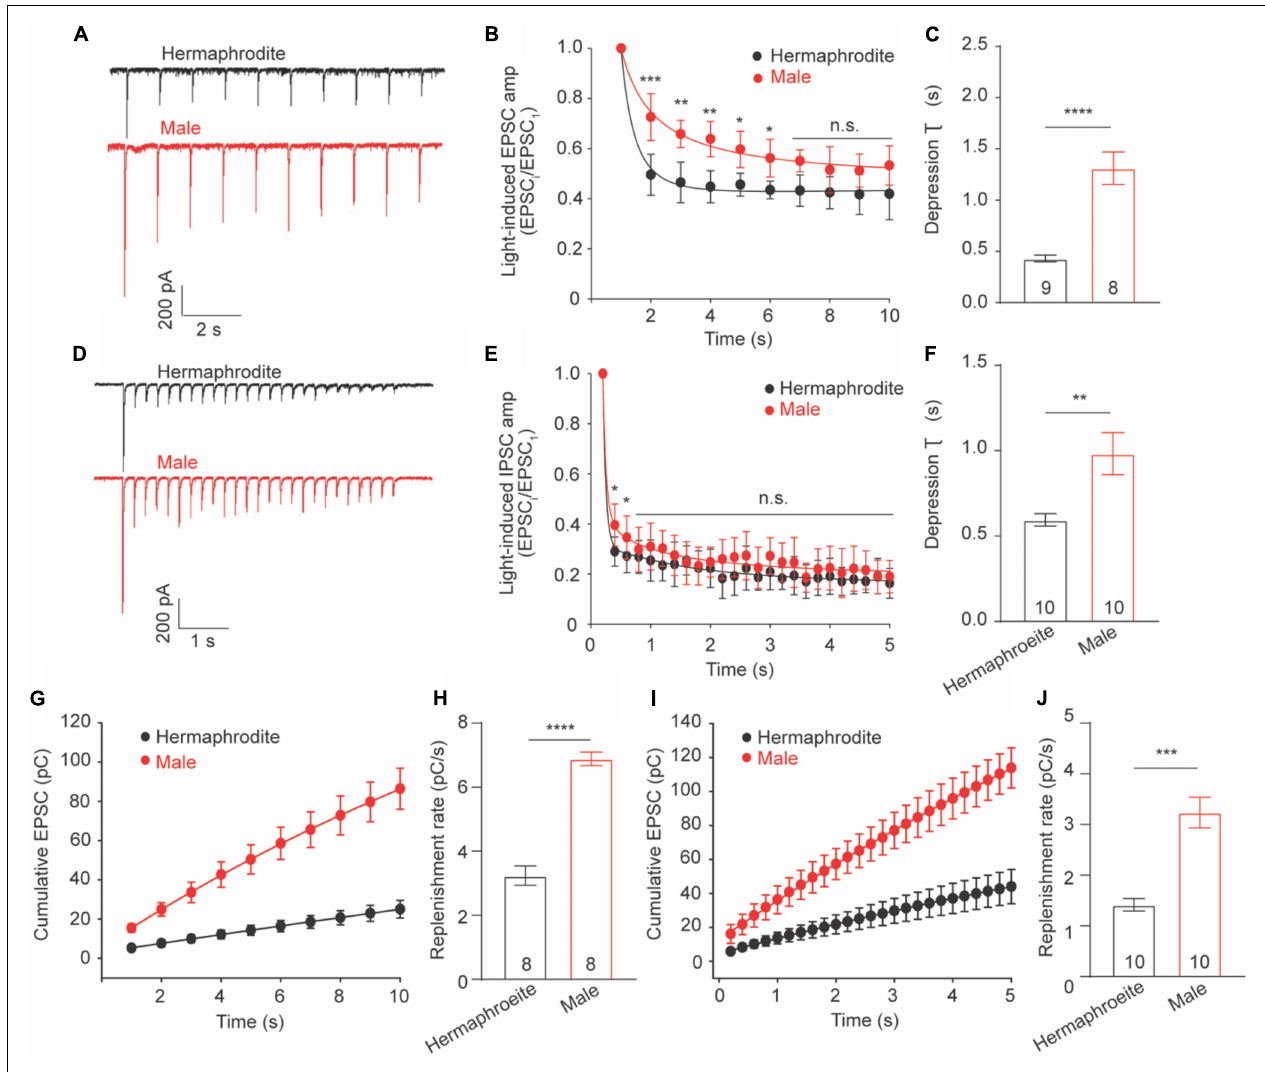
FIGURE 5 | Synaptic depression and replenishment at the NMJs differ between adult hermaphrodite and male C. elegans . Synaptic depression and recovery were investigated by applying a 1 or 5 Hz stimulus train with worms expressing ChR2 in cholinergic motor neurons. Sample traces of 1 Hz (A) and 5 Hz (D) light train stimulus-evoked EPSC. Normalized evoked EPSC amplitude during 1 Hz (B) and 5 Hz (E) stimulation train. Bar graph of the depression index of the normalized amplitude of evoked EPSC in response to 1 Hz (C) and 5 Hz (F) stimulation train. Cumulative charge of evoked EPSC during 1 Hz (G) and 5 Hz (I) stimulation train. Bar graph of the replenishment rates during 1 Hz (H) and 5 Hz (J) stimulation train. Sample sizes (n numbers) are indicated in the bars of each graph. All data are represented as mean ± SEM (* p < 0.05, ** p < 0.01, *** p < 0.001, **** p < 0.0001, n.s. indicates non-significant. t